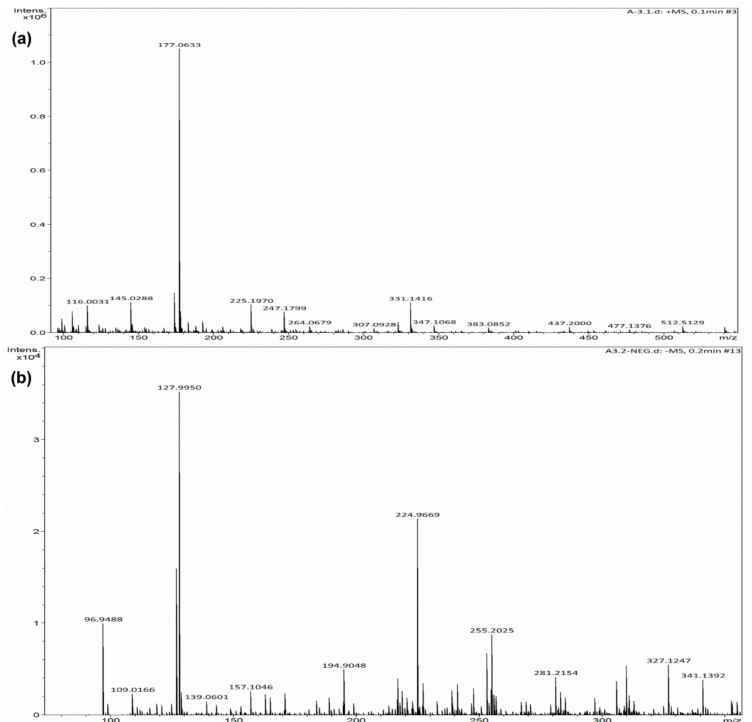
Figure 7. HR-MS peaks for CVD dye ( a ) before degradation and ( b ) after